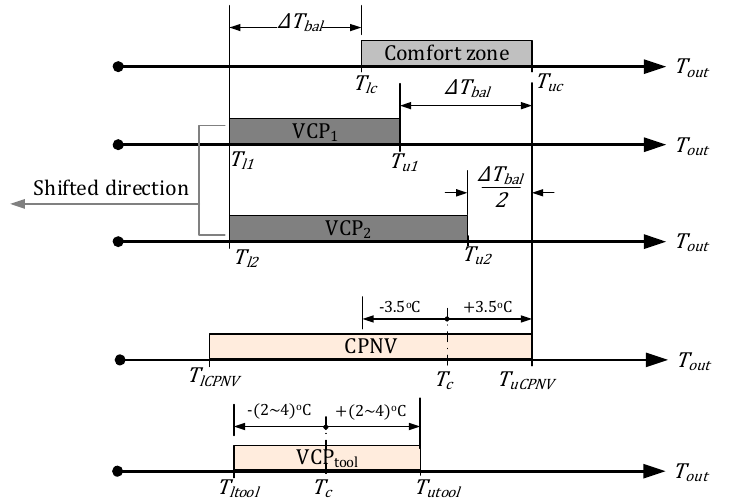
Figure 3. Ventilative cooling potential (VCP) evaluation methods based on temperature ranges. CPNV—climatic potential for natural ventilation.